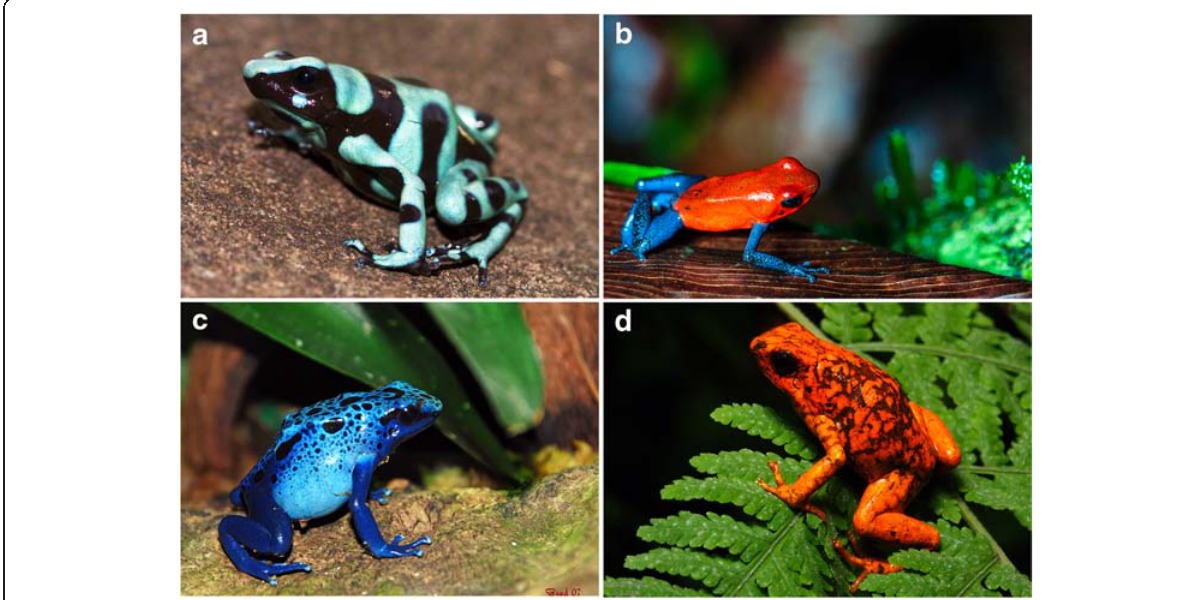
Fig. 1 Examples of Dendrobatidae frogs. a Dendrobates auratus , also known as the green and black poison dart frog or the green and black poison arrow frog ( “ Dendrobates auratus , Bocas del Toro ” by Brian Gratwicke, CC BY 4.0, https://flic.kr/p/ajE9io). b Oophaga pumilio , strawberry poison frog or strawberry poison dart frog ( “ Blue jeans frog ” by Danel Solabarrieta, CC BY-SA 2.0, https://flic.kr/p/gRYCXh). c Dendrobates azureus , the blue poison dart frog or blue poison arrow frog ( “ Frog, Dendrobates azureus ” by Brad Francis, CC BY-ND 2.0, https://flic.kr/p/4fx2Zx). d Oophaga sylvatica ( “ Little-devil poison frog, Oophaga sylvatica from Provincia Esmeraldas, Ecuador ” by Santiago R. Ron-FaunaWebEcuador, CC BY-ND 2.0, http://zoologia.-